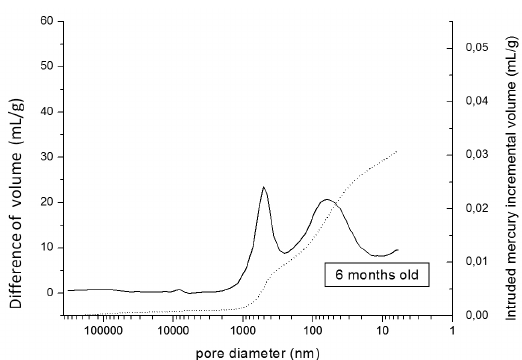
Figure 14. Porosimetry of fiber cement C at six months of age.